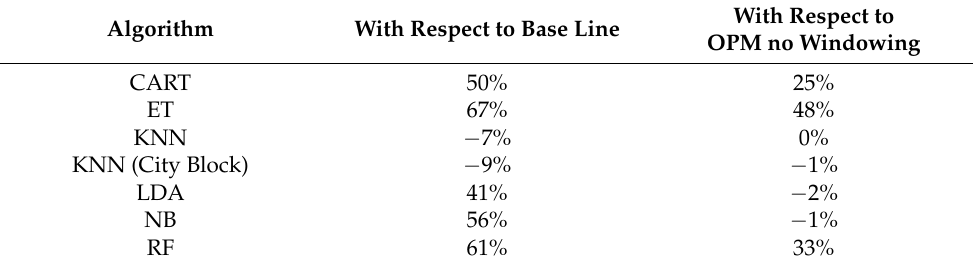
Table 7. Percentage decrease in processing time.